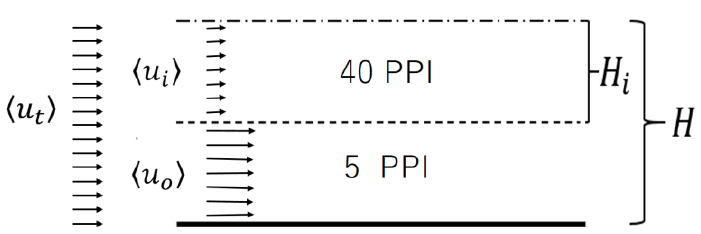
Figure 2. Schematic view of velocity distribution for inner and outer regions in the half of the